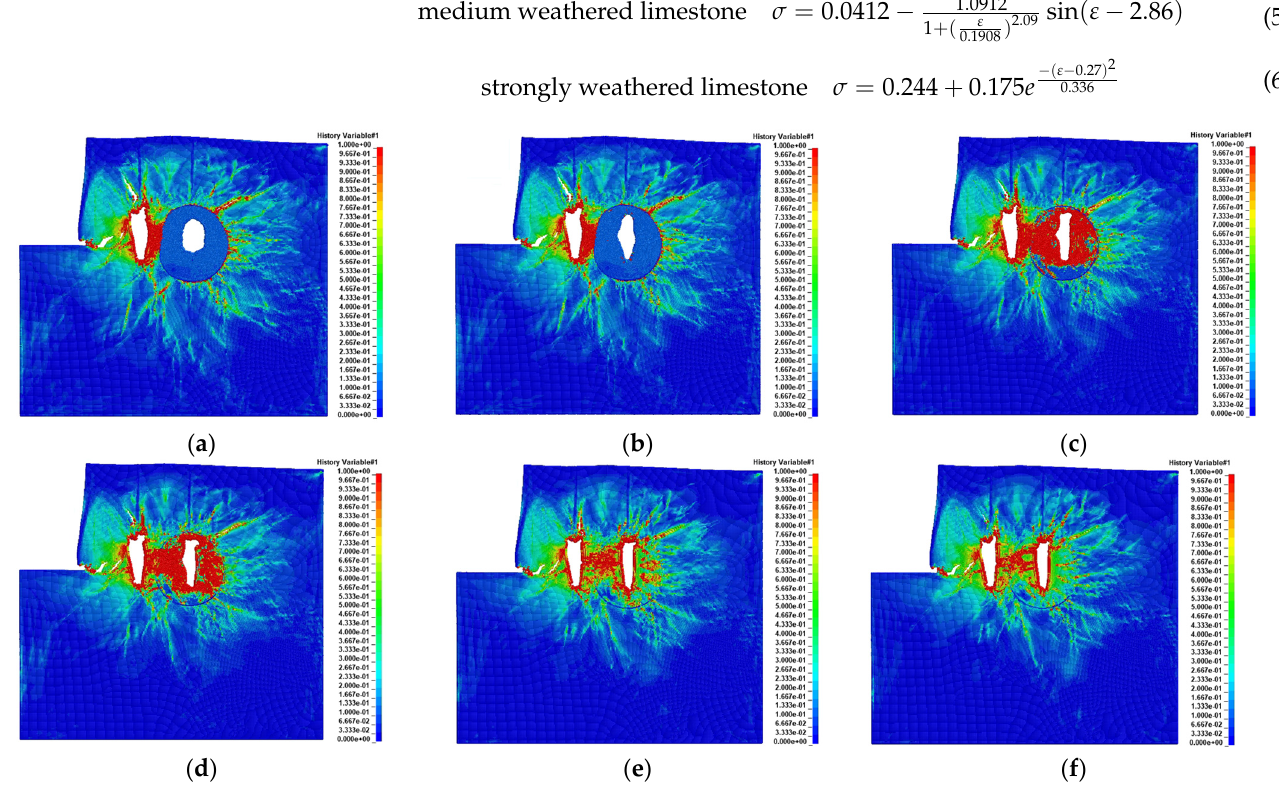
Figure 15. Rock-breaking effect of cement mortar with different stiffness. ( a ) ε = 0.1%; ( b ) ε = 1%; ( c ) ε = 10%; ( d ) ε = 20%; ( e ) ε = 60%; ( f ) ε = 100%. ( c ) ε = 10%; ( d ) ε = 20%; ( e ) ε = 60%; ( f ) ε =